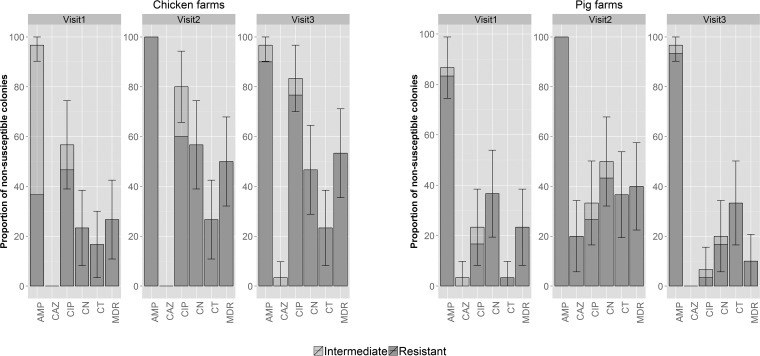
Prevalence of AMR among 180 E. coli isolates (30 isolates/visit/host species) from 12 farms in Tien Giang, Vietnam (2013–2014). The error bars indicate 95% confidence intervals. AMP, ampicillin; CAZ, ceftazidime; CIP, ciprofloxacin; CN, gentamicin; CT, colistin.